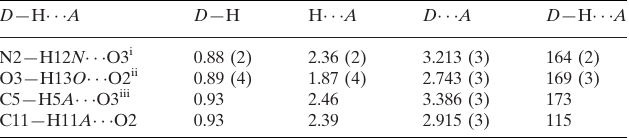
Data collection Bruker SMART APEXII DUO CCD area-detector diffractometer Absorption correction: multi-scan